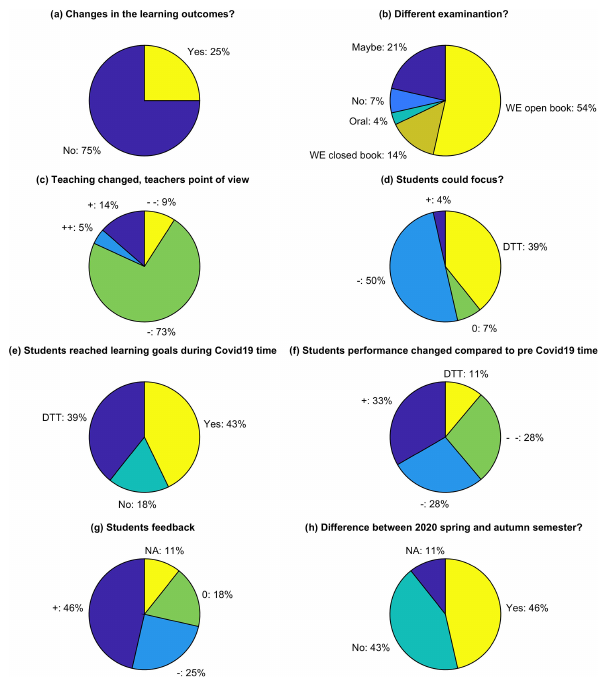
Figure 7. The percentage of respondents indicating that (a) the learning outcomes changed, (b) different examinations were used (written exam as WE), (c) teaching changed from a teacher’s point (d) , students could focus, students could reach learning goals dur- ing COVID-19 measures (e) , students’ performance changed com- pared to pre-COVID-19 measures (f) , the student feedback (g) and whether there was a difference in teaching between the 2020 spring and autumn semesters, with positive or more ( + ), neutral (0), nega- tive (–), very negative (–), and difficult to tell